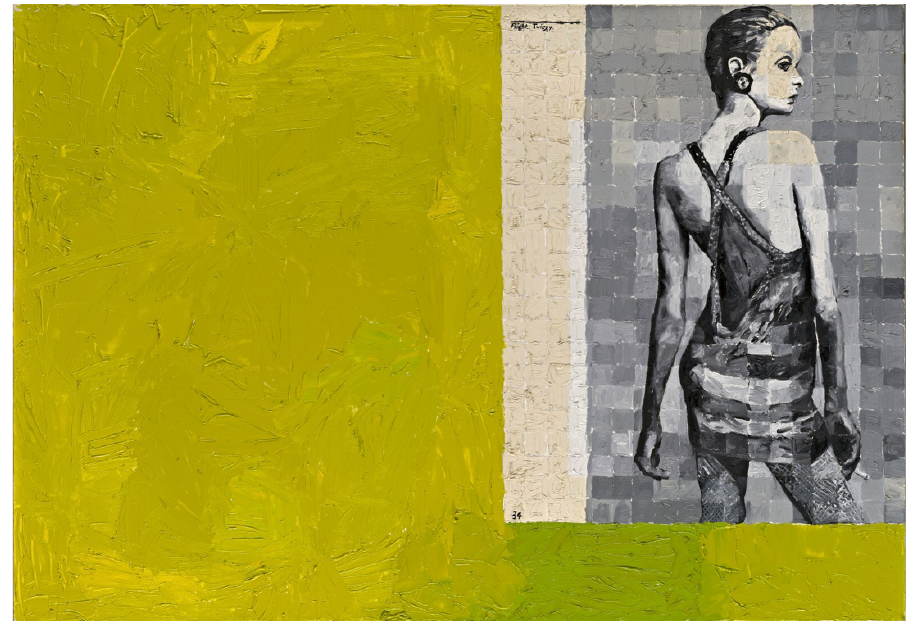
Jenny Watson, A Painted Page 1: Twiggy by Richard Avedon , 1979, oil on canvas, 105 x 153 cm,